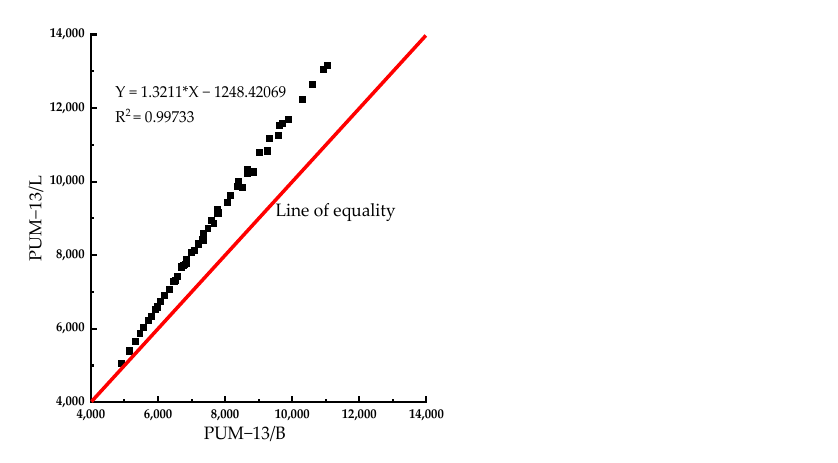
Figure 12. The line of equality about the dynamic modulus of the PU mixture with the same gradation and different aggregate types. Table 5. Statistically significant effect of aggregate type in the dynamic modulus and phase